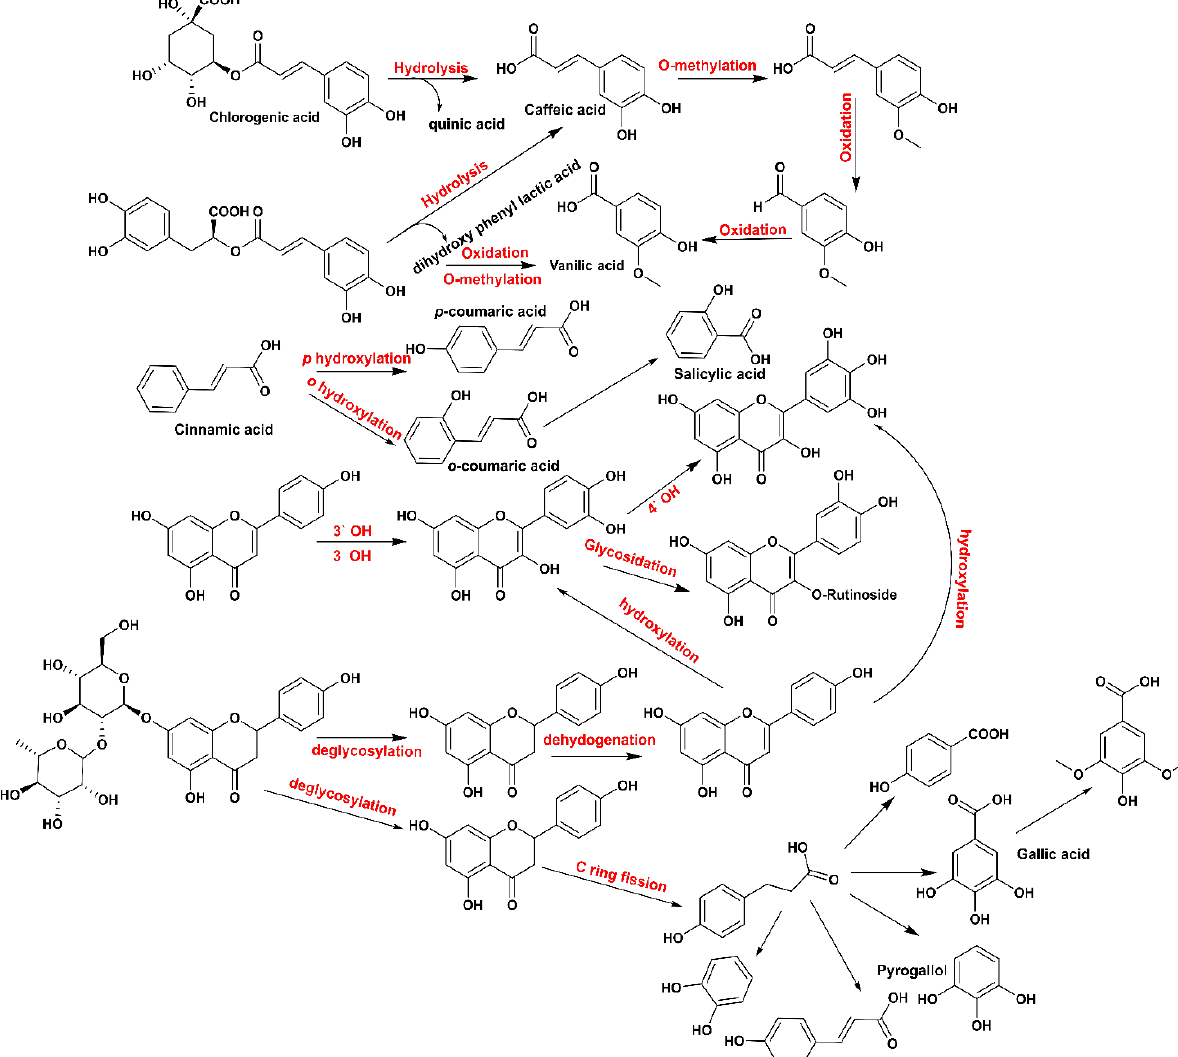
Figure 8. Proposed scheme for changes of the phenolic contents.